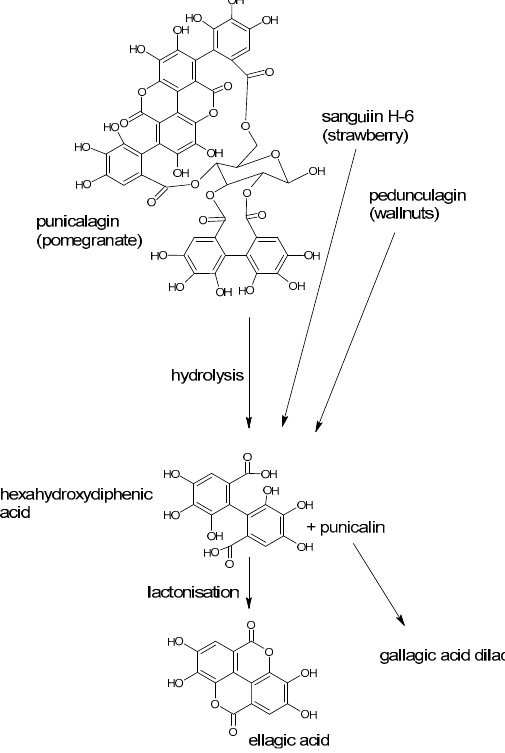
Figure 9. Degradation of ellagitannins to ellagic acid. Based on [268].